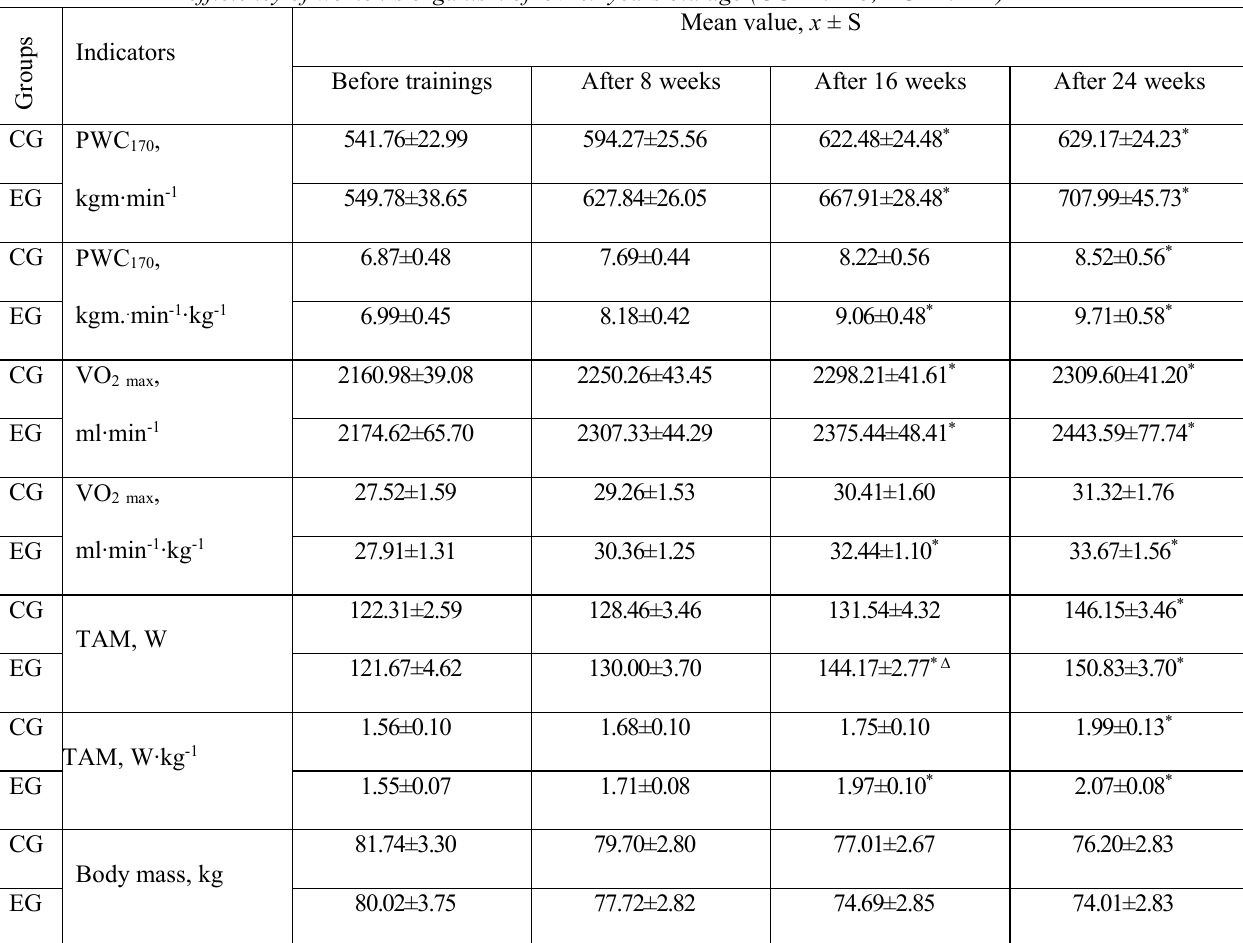
Influence of aqua-fitness trainings with application of normobaric hypercapnic hypoxia and without it on